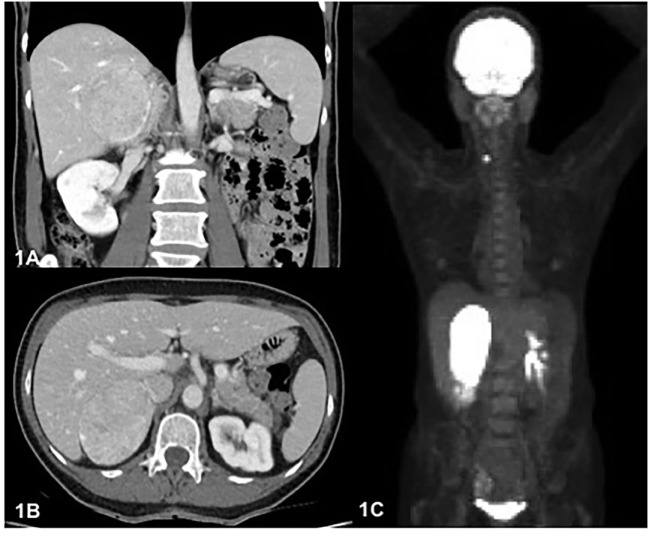
(A). Axial image on portal phase computed tomography (CT) scan showing right adrenal mass heterogeneously enhanced of 7.6 cm × 5.8 cm. (B). Cross-sectional image on CT scan showing right adrenal mass with imprint on the liver. (C). Maximum intensity projection image on FDG positron emission tomography showing the two hypermetabolic masses, right adrenal, and right thyroid lobe.